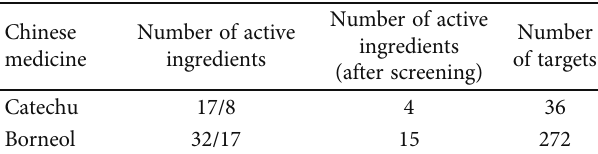
Table 1: Compatibility of traditional Chinese medicine compounds-active ingredients-target